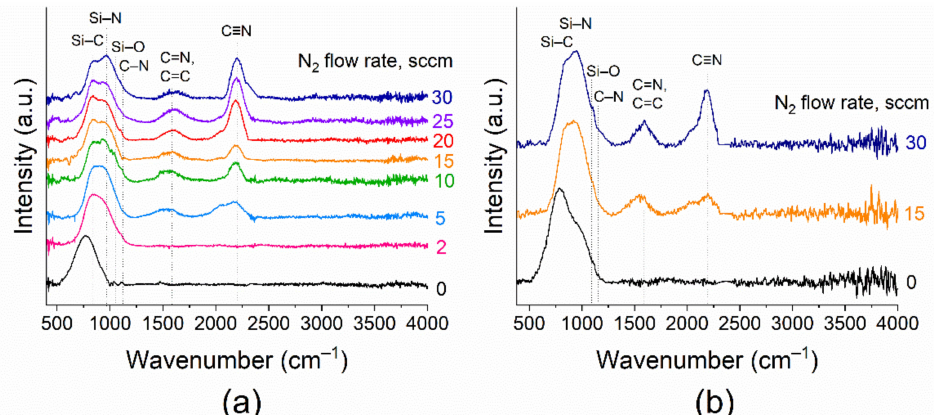
Figure 5. FTIR spectra evolution of SiC x N y films obtained by sputtering at ( a ) room temperature and ( b ) 300 ◦ C with the different nitrogen flow (series A and